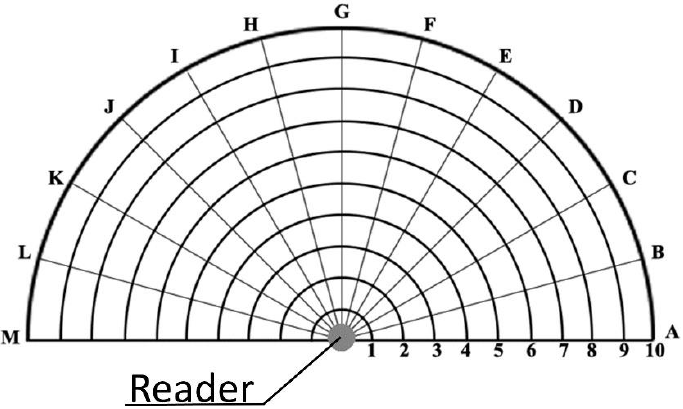
Figure 4. Measurement points used during the first assessment.